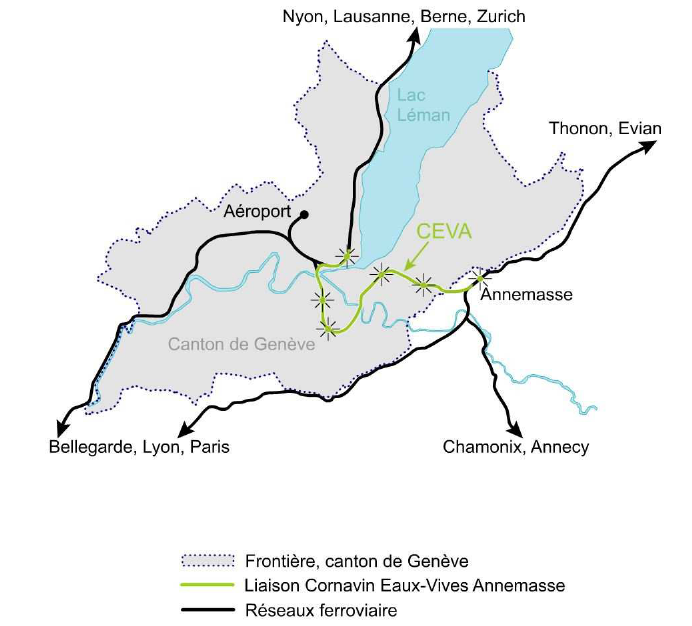
Figure 4. The CEVA rail line project Source: République et Canton de Genève, CFF